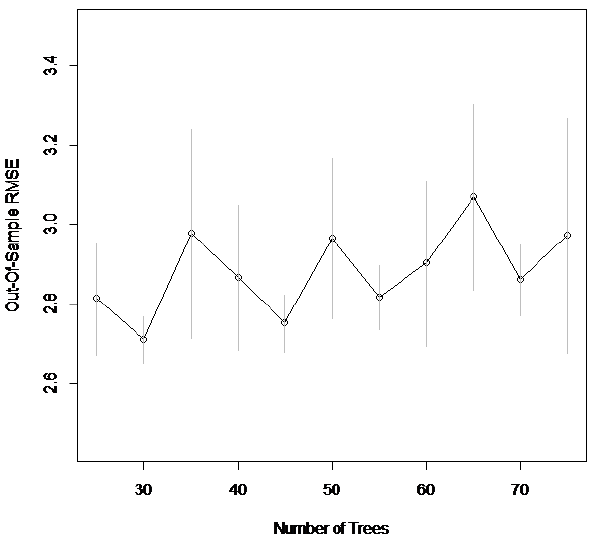
Figure 10. RMSE for prediction performance by number of trees.